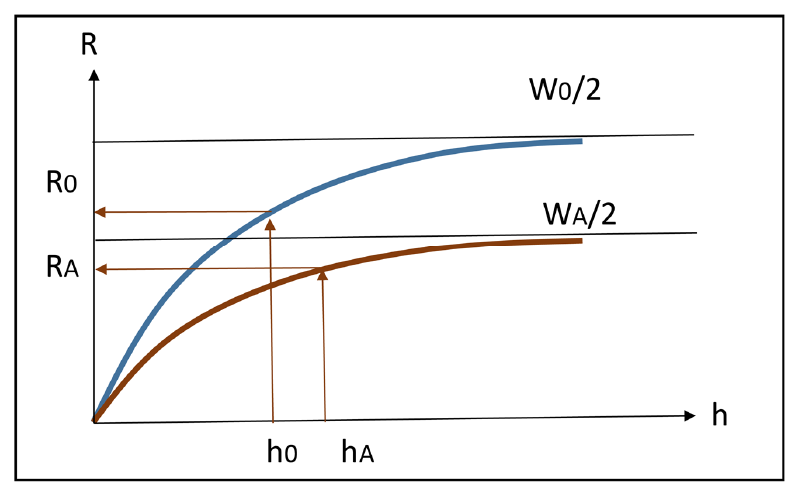
Figure A1. The hydraulic radius R (h,w) as a function of water depth (h) and channel width (w) for a rectangular channel.